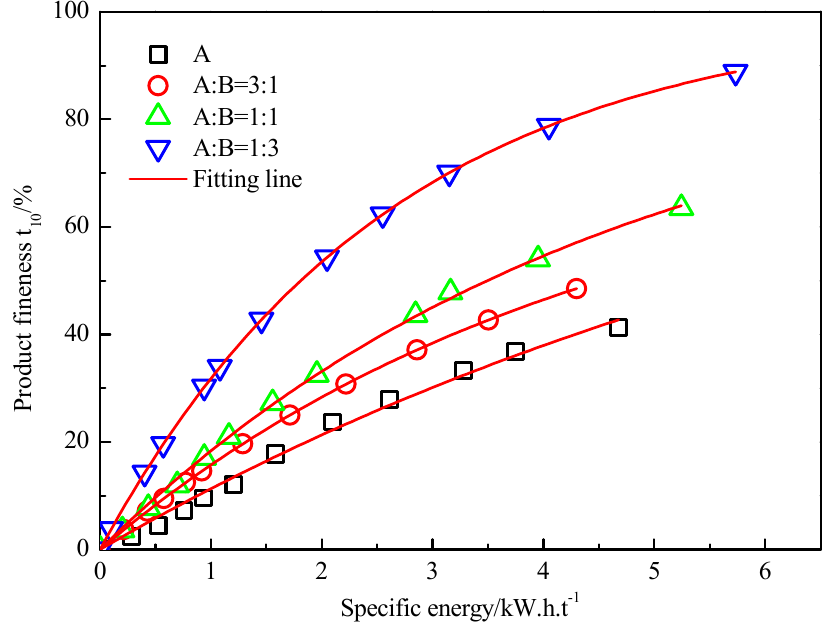
Figure 8. Specific energy vs product fineness t 10 of anthracite in mixture breakage.